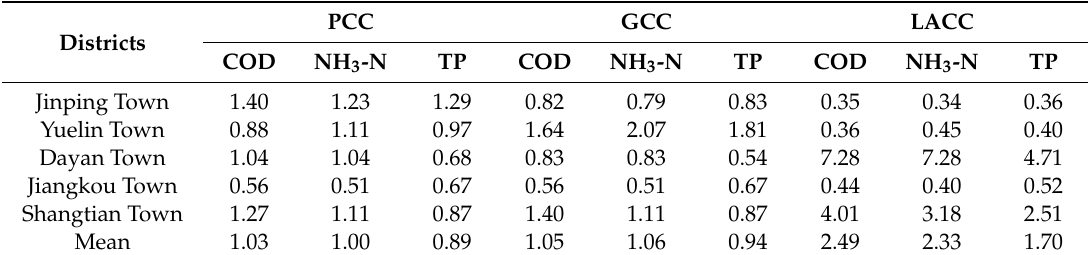
Jiangkou Town 0.56